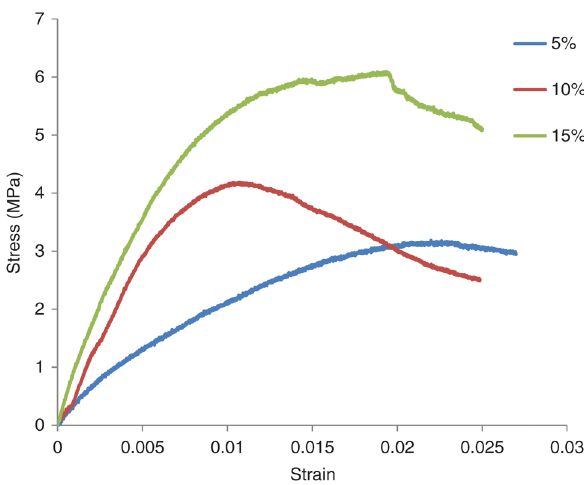
Figure 8: Stress-strain curve for samples prepared at 80°C temperature and 70 bar pressure.